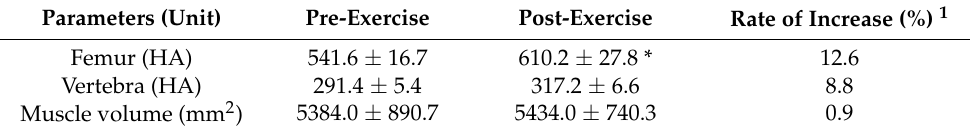
Table 2. Analysis of bone mineral density and muscle volume before and after exercise in dogs.